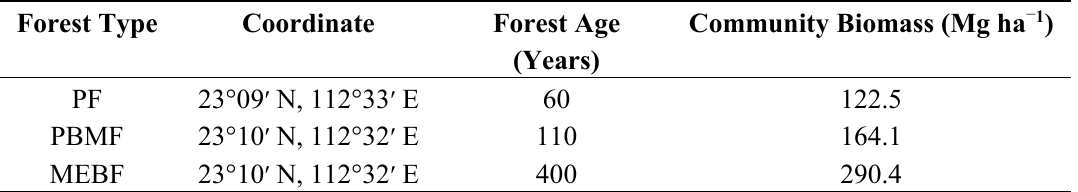
Table 1. Characteristics of the three